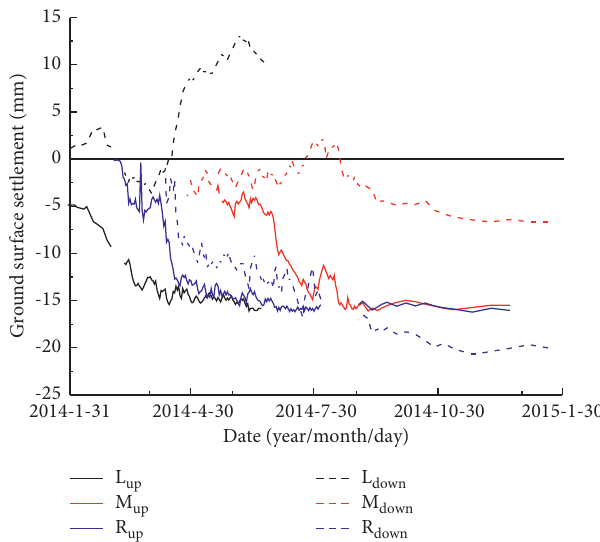
Figure 12: Ground surface settlement duration curves at 3m distance from the retaining structures.